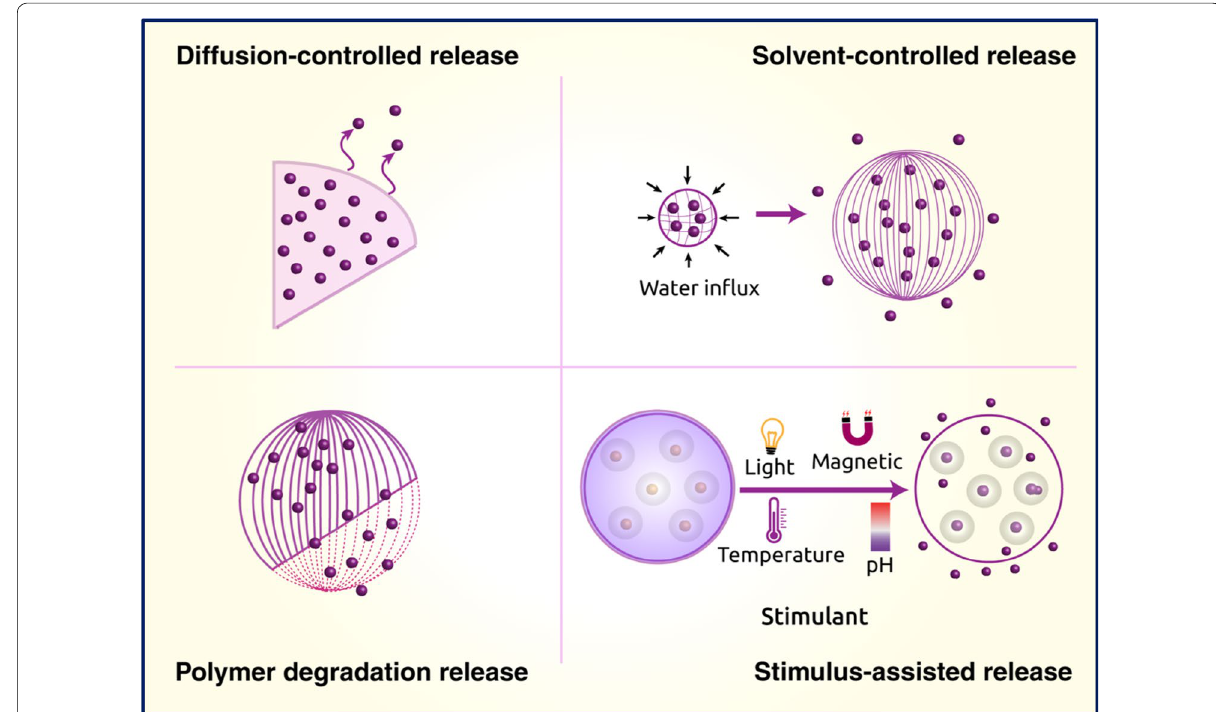
Fig. 4 Schematic depiction of diffusion-, solvent-controlled, polymer degradation, and other stimuli reliant drug